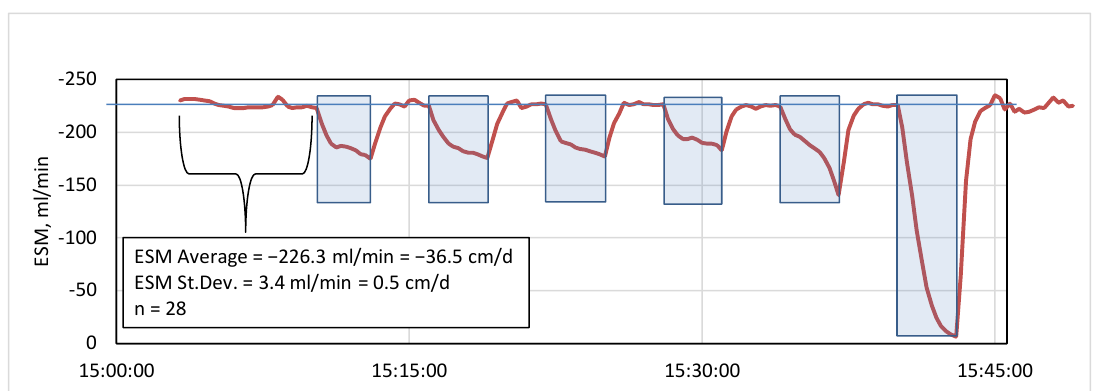
Figure 3. ESM output in ml/min with average values provided every 15 s. Blue rectangles are periods during seepage bag attachment efficiency measurements. Horizontal blue line indicates the average ESM value when no bag is attached. ESM average, standard deviation, and n are for periods with no bag attachment when output was stabilized.